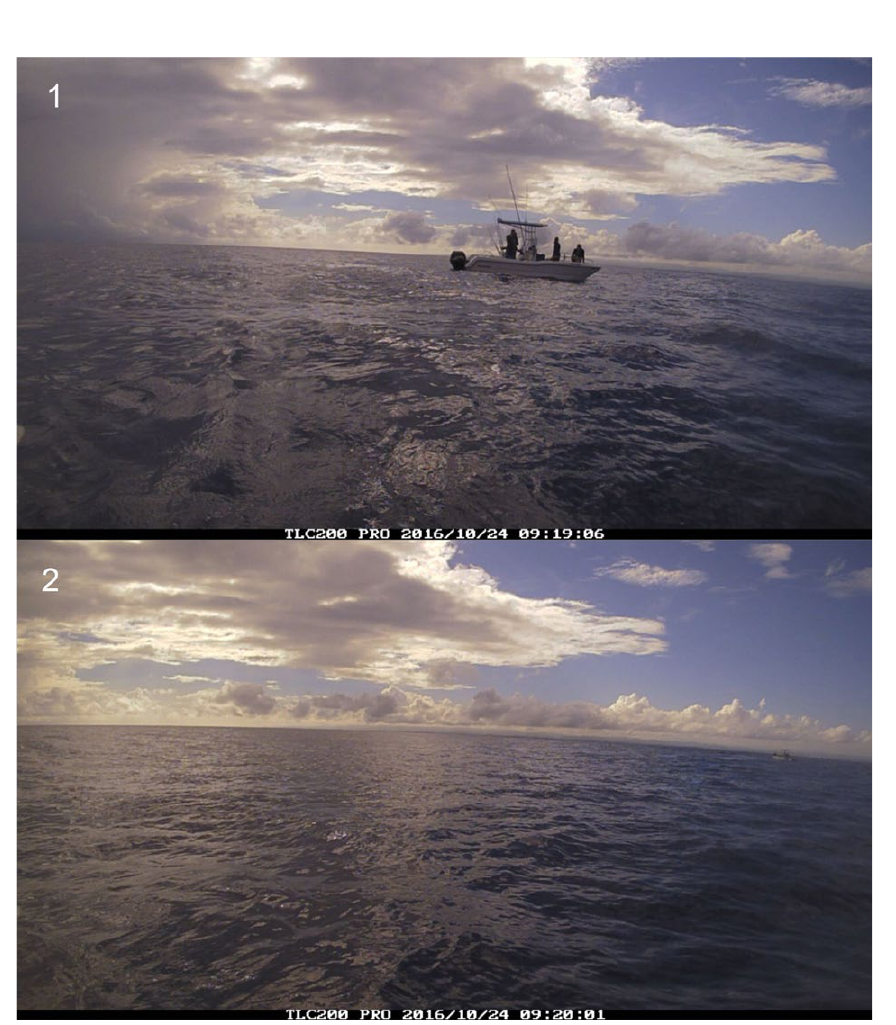
Fig. S1. – A camera was redeployed to conduct a range test to determine approximately how far a vessel in an image was from the FAD. Image (1) is a vessel that is 70 metres from the FAD; Image (2) is the same vessel 132 m from the FAD. These photos were used to determine the proximity of vessels to the